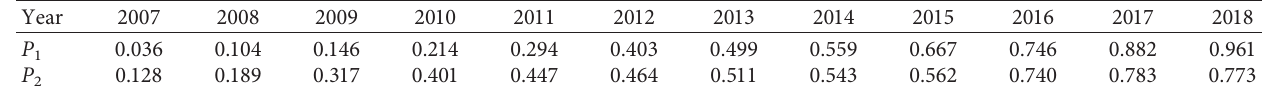
Table 6: Composite indices.